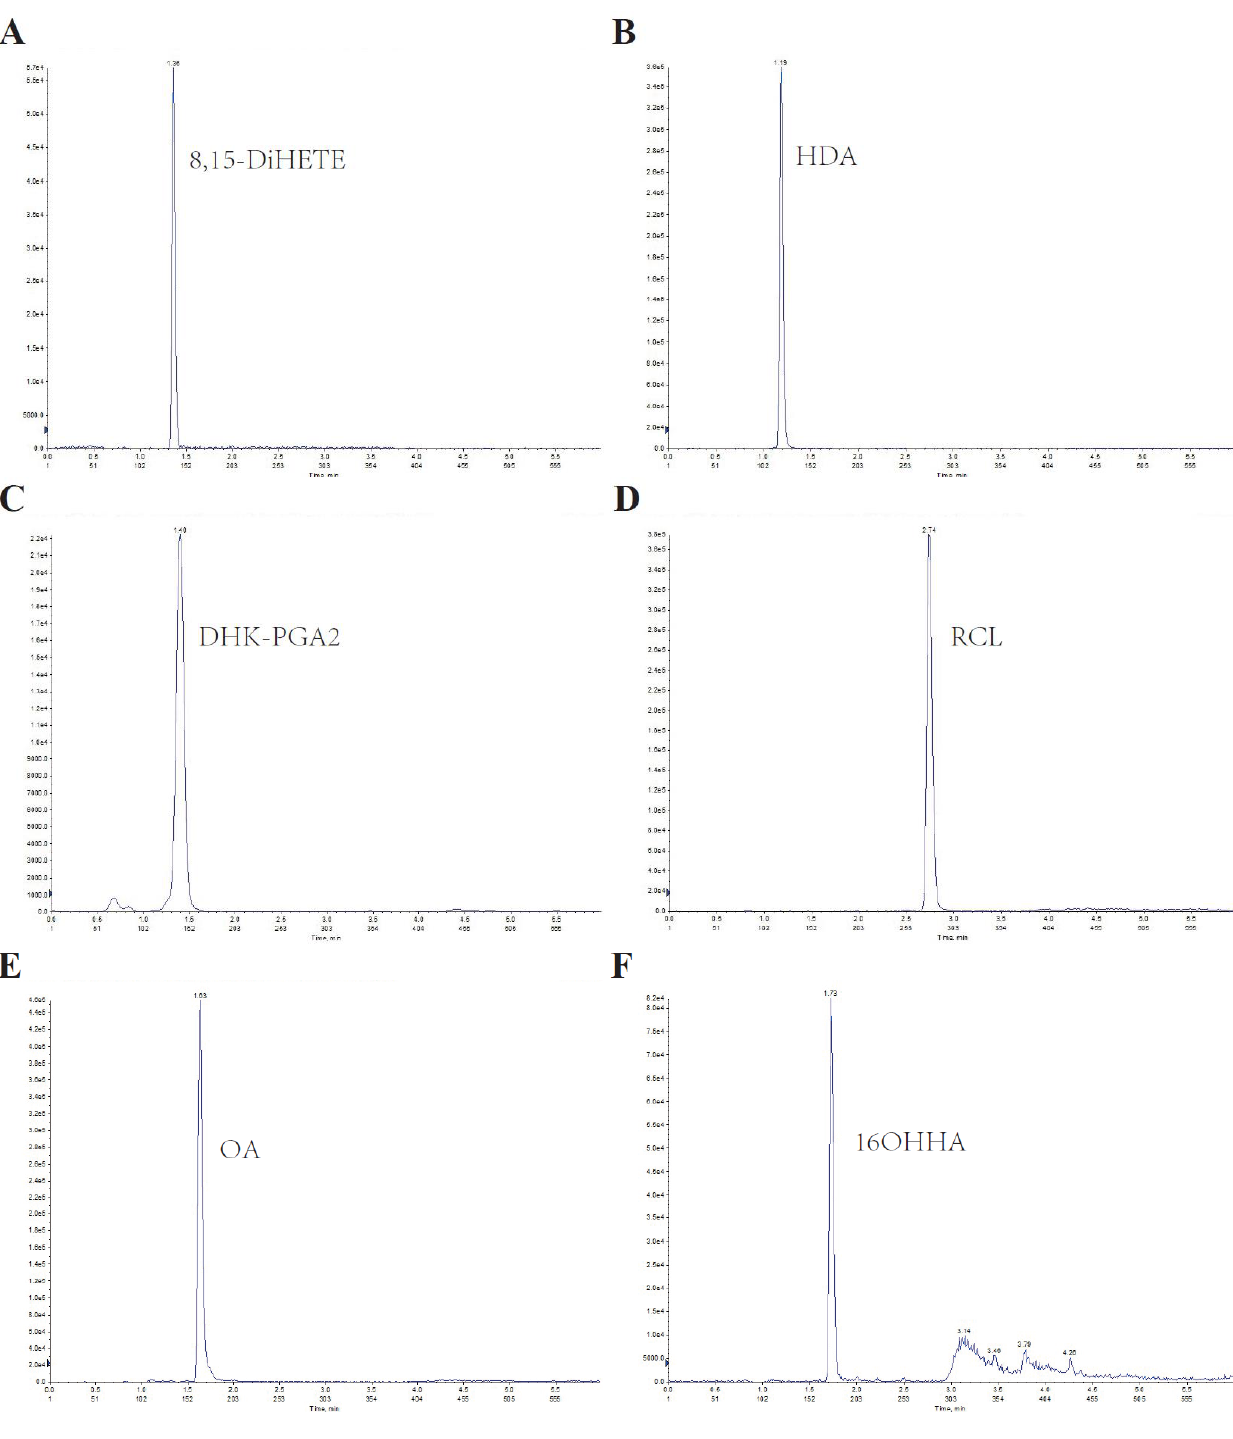
Figure 1. Representative chromatography of the LC – MS/MS method for serum lipids. ( A – F ) repre- sent the chromatography of 8,15-DiHETE, HDA, DHK-PGA2, RCL, OA, and 16OHHA, respectively. Then, the method validation was carried out to evaluate the linearity, linear range, precision, and recovery of the above analytical method (Table 2). The linear r 2 for each calibration curve was >0.99, suggesting a great linearity for all of the serum lipids. The intra- and inter-day imprecisions were evaluated using low and high QC samples, and the coefficient variations (CVs) were <10%. Recovery was assessed at three different